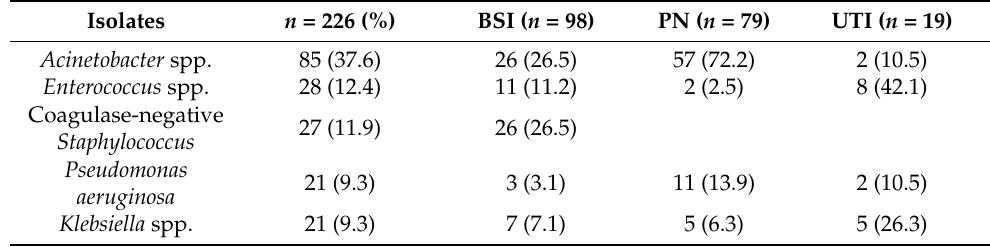
Table 2. Causative agents of HAIs that underwent AST from 1 April 2019–31 March